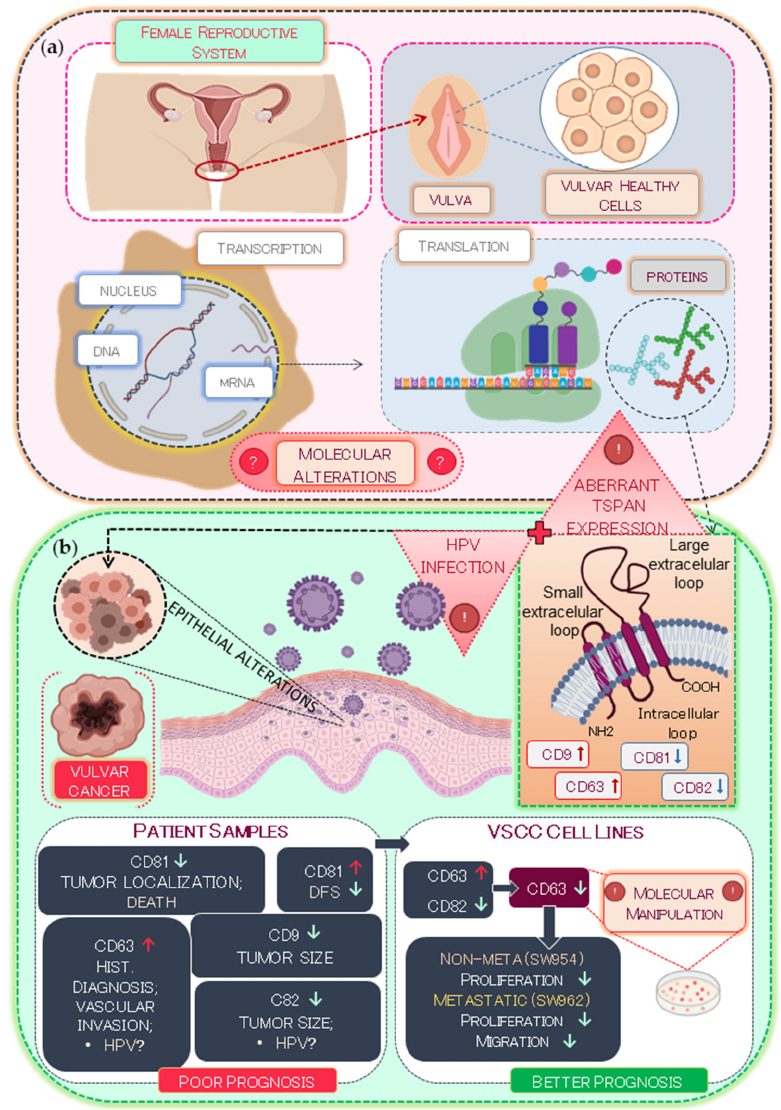
Figure 6. Schematic illustration of TSPAN expression and their prognostic value for VSCC patients. ( a ) During the TSPAN transcription and translation processes, genetic or epigenetic alterations may occur at the molecular level, leading to loss or gain of expression of certain TSPANs that can contribute to several pathogenic processes. ( b ) These alterations, together with high-risk HPV infections, may be associated with larger tumor size, lymph node metastasis, and lower DFS rates, which represent a poor prognosis for VSCC patients. CD63 is related to increased cell survival and migration in the VSCC in vitro analyses. Red and green arrows indicate upregulation and downregulation of genes.